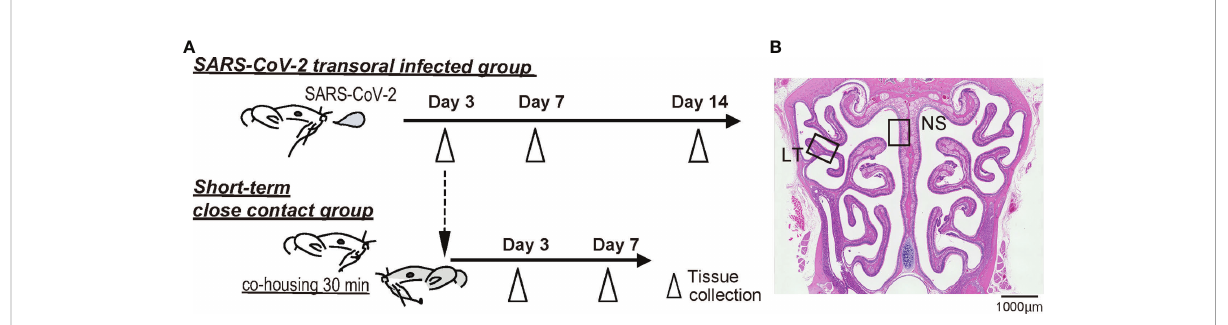
FIGURE 1 Experimental timeline and nasal structure. (A) Hamsters were administered orally severe acute respiratory syndrome coronavirus 2 (SARS-CoV- 2) (1.0×10 3 pfu). To prepare the short-term close-contact models, the uninfected hamsters were cohoused for 30 minutes with SARS-CoV-2 infected hamsters (3 days after SARS-CoV-2 inoculation), and then separated. (B) Representative images of the olfactory epithelium from control hamsters. The boxes indicate the regions of the dorsal nasal septum (NS) and lateral turbinate (LT)